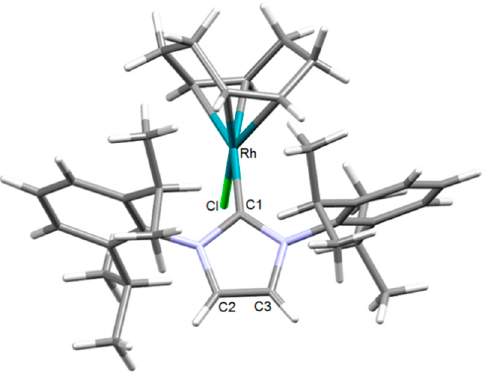
Figure 3. Capped sticks representation of the solid-state structure of [RhCl(cod)(IPr)]( 3 ) crystallized from benzene ([RhCl(cod)(IPr)]_benzene_ 3 ; benzene molecules are omitted for clarity.